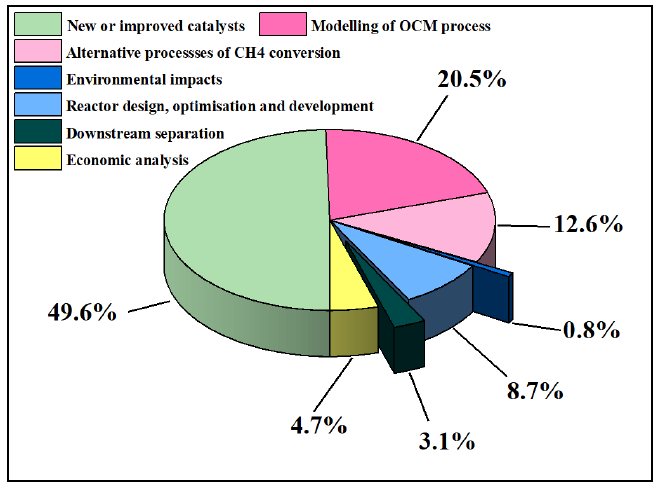
Figure 6. Distribution of topics in the extracted sample of scientific papers, containing 120 manu- scripts published between 2016 and 2020.